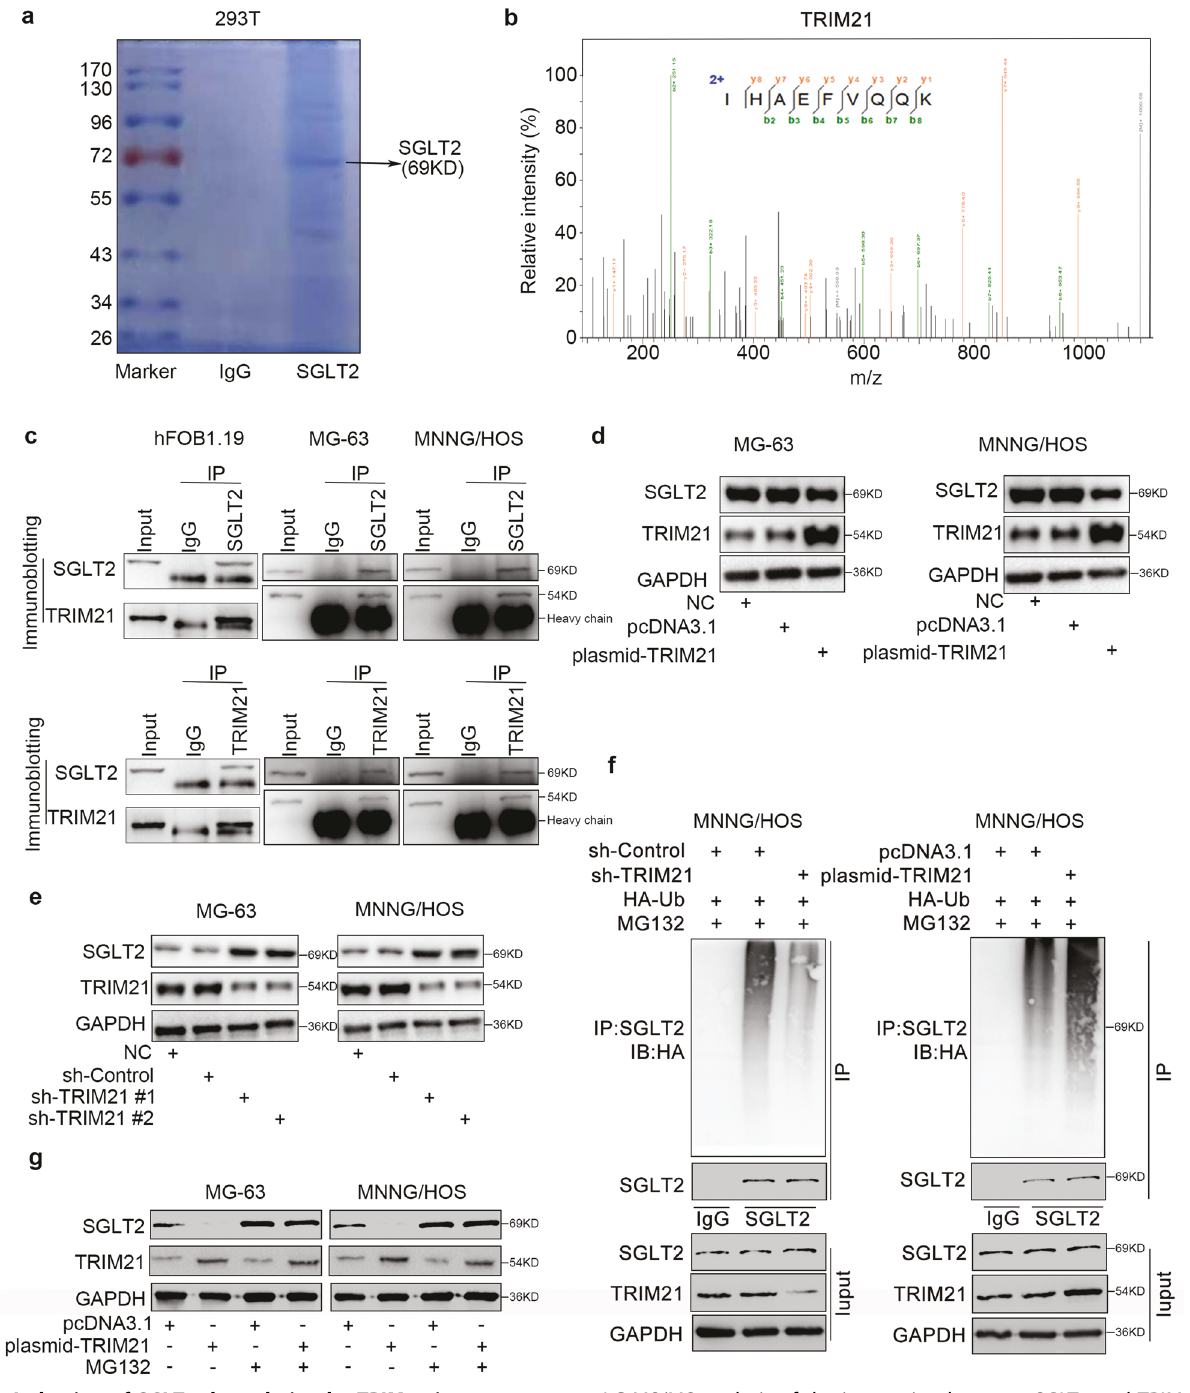
Fig. 2 Induction of SGLT2 degradation by TRIM21 in osteosarcoma. LC-MS/MS analysis of the interaction between SGLT2 and TRIM21 ( a ) based on the detection of the peptide of TRIM21 ( b ). c Analysis of the interaction between SGLT2 and TRIM21 by co-immunoprecipitation. Western blot analysis of the protein expression levels of SGLT2 in TRIM21-overexpressed ( d ) and -silenced ( e ) MG-63 and MNNG/HOS cells. GAPDH served as an internal reference. f Western blot analysis in MG-63 cells transfected with sh-TRIM21 or TRIM21 plasmid for 48 h. Cells were treated with MG132 for 8 h before harvesting. g Western blot analysis of the protein expression levels of SGLT2 in TRIM21-overexpressed MG-63 and MNNG/HOS cells for 48 h. Cells were treated with MG132 for 8 h before harvesting. GAPDH served as an internal reference. normal osteogenic tissues (Fig. 1f, g). Taken together, this result protein expression level of SGLT2 was signi fi cantly upregulated in indicated that SGLT2 was overexpressed in osteosarcoma at the osteosarcoma patient specimens (Fig. 1c). A similar effect was protein level but not at the mRNA level, and the expression observed in a normal osteogenic cell line and osteosarcoma cell lines regulation of the overexpressed SGLT2 might occurred at the protein (Fig. 1d, e). Furthermore, IHC analysis showed that SGLT2 was level but not at the mRNA level in osteosarcoma. signi fi cantly overexpressed in osteosarcoma tissues compared with Cell Death and Disease (2022)